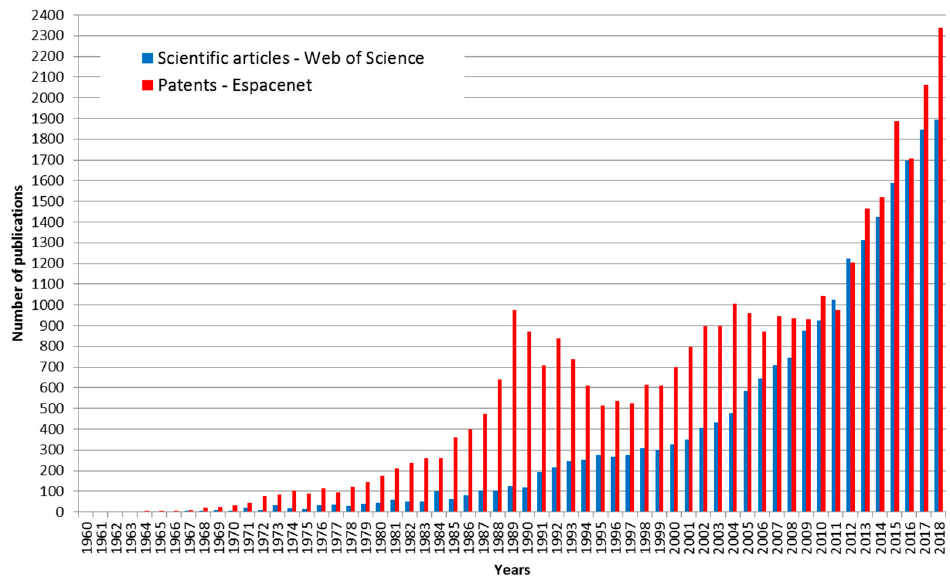
Figure 1. Annual number of new publications on microencapsulation (Web of Science and Espacenet databases, search profile: microcapsul* OR microencapsul*).